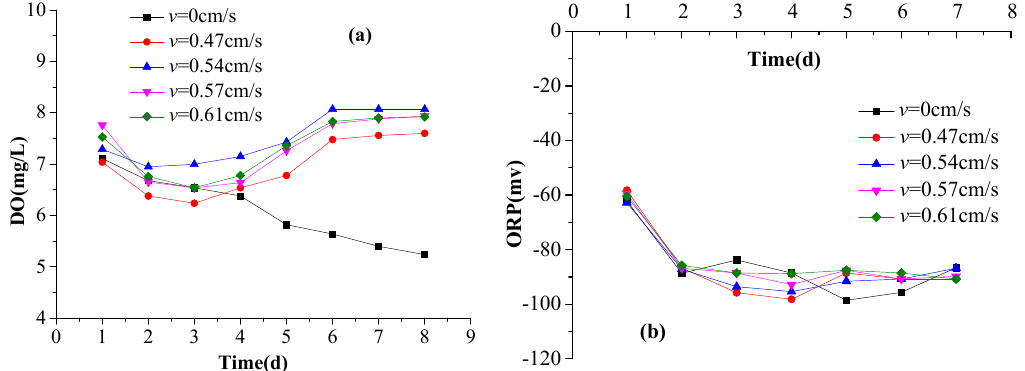
Figure 4. ( a ) Dissolved oxygen (DO) concentrations; and ( b ) oxidation ‐ reduction potentials (ORP), in the overlying water during the experiment.